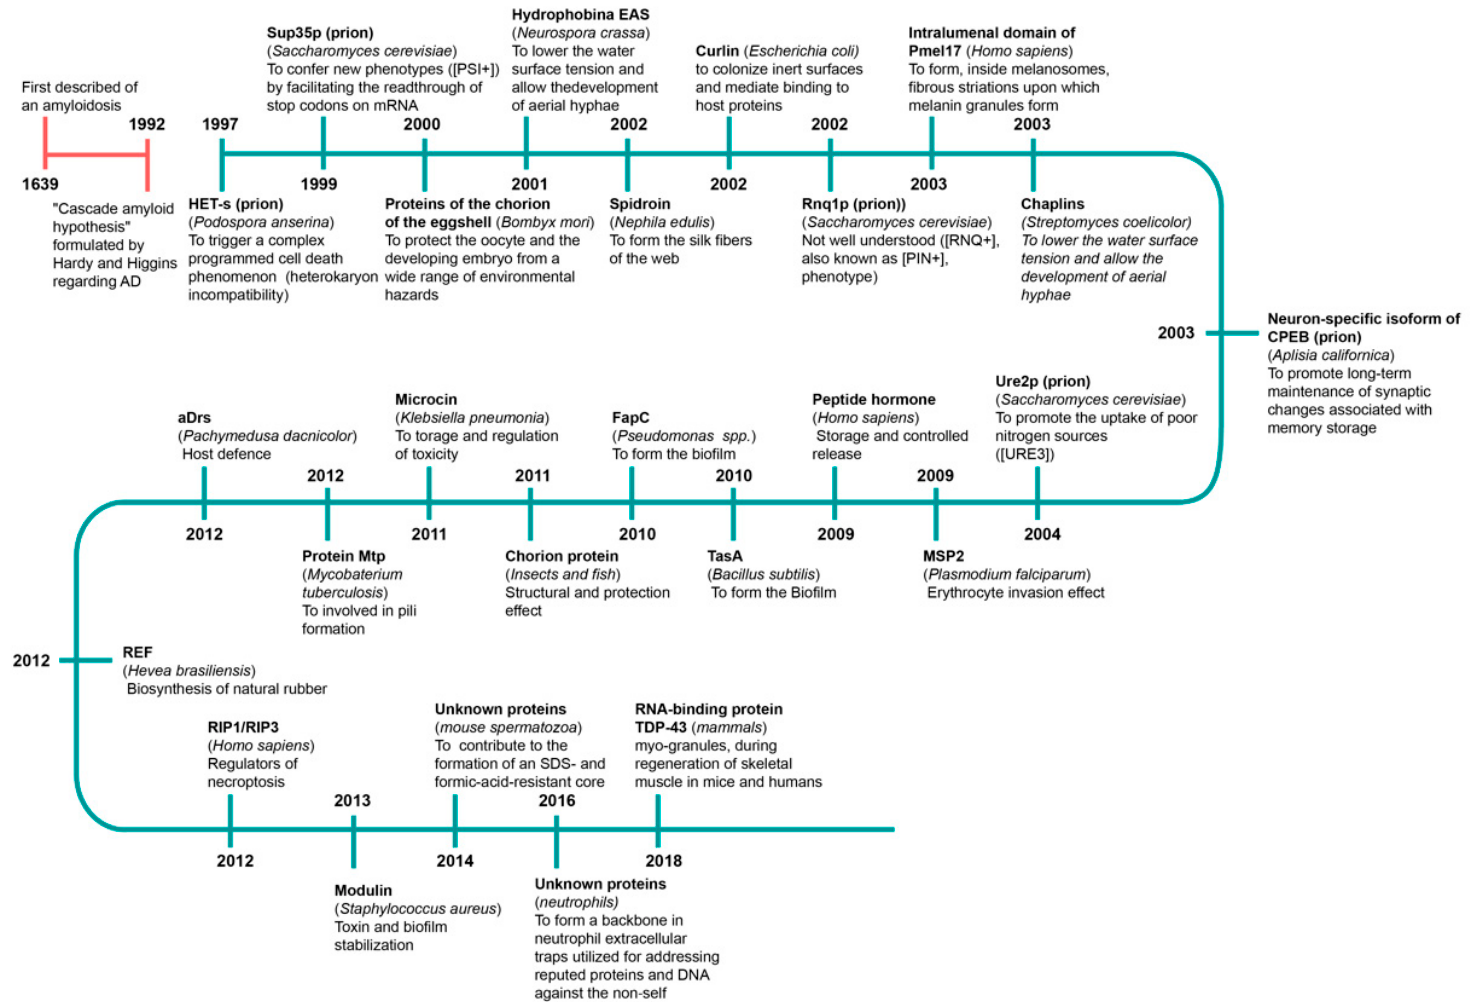
Figure 2. Timeline of history of functional amyloid discoveries. The name, host and function are presented. Functional amyloids have various roles (Table 1), from formation of dense hydro- phobic monolayers on the surface of spores and fruiting bodies of some fungi [166] to formation of the carcass of spider silk [15]; from protection of melanin toxic intermediates in melanosomes [16,17] to formation of long-term memory in animals [16,170]. They are involved in the fertilization process in mice [17] and regulation of the synthesis (or con- tent) of hormones in humans [19]. Recent data indicate that amyloid aggregates can par- ticipate in immune responses because they are part of the extracellular neutrophil trap [171]. Functional amyloids are found in muscle tissue. It has been shown that, during re- generation of skeletal muscles in mice and humans, the cytoplasmic RNA-binding protein TDP-43 forms amyloid-like oligomers called myogranules [172]. Amyloids have also an RNA-modulating ability and play a role in transcription, translation, storage and degra- dation of RNA [173]. It has been shown that some motifs in prions of fungi and humans can be functionally related and be a model of amyloid signaling mechanisms from fungi to mammals [174,175]. Prokaryotic cells can also use such properties [8]. Just as people can store hormones in amyloids, plants can also store their protein using amyloid for- mation [8].